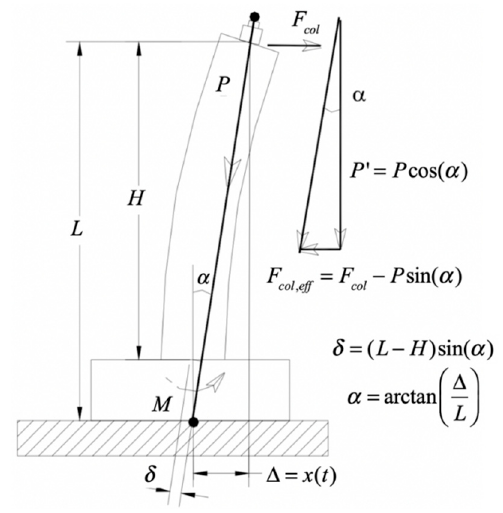
Figure 9. P- Δ effect due to the axial load. Figure 9. P- ∆ effect due to the axial